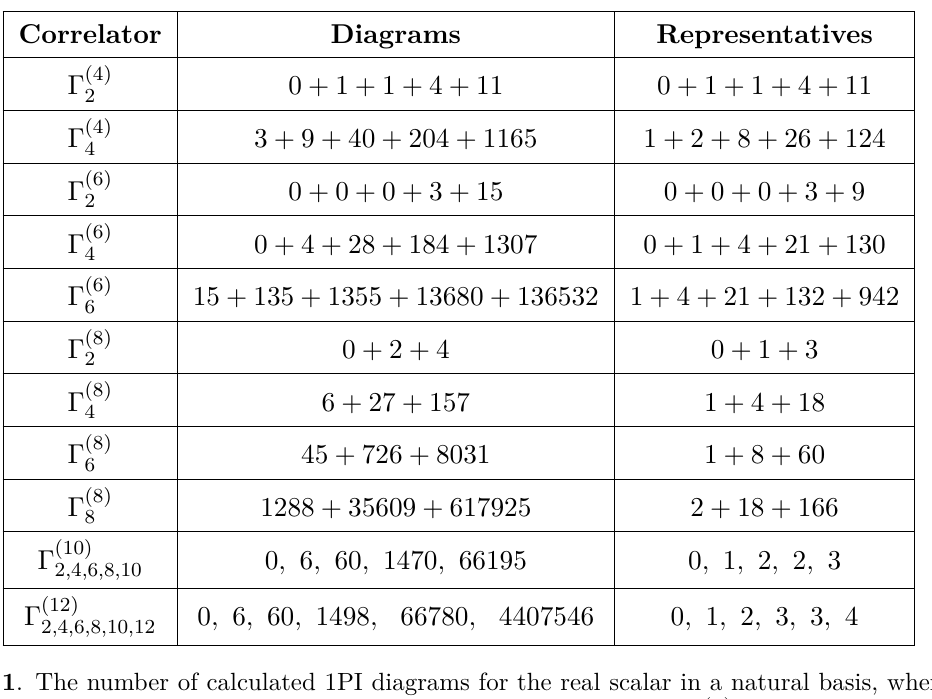
refers to the correlator N